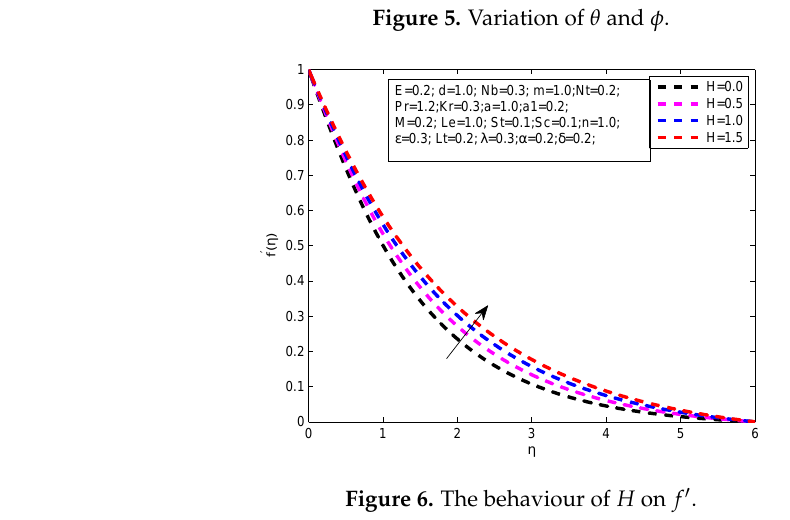
Figure 5. Variation of θ and φ .